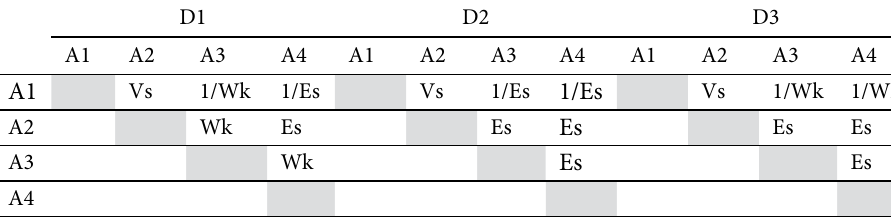
Table 8. DMs’ Evaluation for Alternative with respect to C11 D1 D2 D3